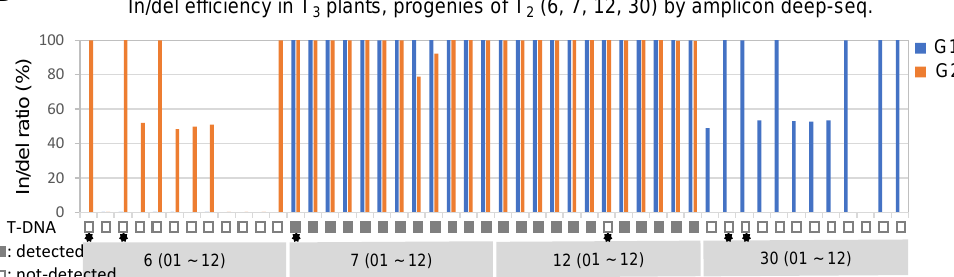
Figure 1. A schematic diagram depicting the study design and the insertion/deletion (in/del) efficiencies of individual transformants generated by CRISPR-mediated multiple-target mutagenesis in Arabidopsis . ( A ) A schematic illustration depicting the flow of this study. A single single-stranded guide RNA (sgRNA) that simultaneously targets two genes, AT5G46510 (G1) and AT5G46520 ( ACQOS / VICTR ; G2), as well as Sp Cas9, were expressed in Arabidopsis plants following Agrobacterium -mediated transformation to introduce in/del mutations. Transgenic seedlings in the fourth generation (T 4 ) with desirable allele combinations confirmed in T 3 parental plants were subjected to salt stress. Salt stress sorbitol treatments were applied to the seedlings of transgenic plants of the fourth generation (T 4 ) for 7 days, followed by 7-day acclimation to sodium chloride (NaCl). Then, the chlorophyll contents of aerial tissues harvested from 28-day-old seedlings were measured as an indicator of salt tolerance. ( B – D ) In/del mutation efficiencies of individual transgenic plants of the first ( B ), second ( C ), and third ( D ) generations measured by amplicon deep sequencing for AT5G46510 (G1) and ACQOS (G2). Transformants containing traces of T-DNA are indicated with closed (detected) or open (not-detected) squares. Asterisks indicate the mutant lines taken forward to the next generation in ( B , C ) and the parental lines of T 4 seedlings in ( D ) used in downstream experiments.